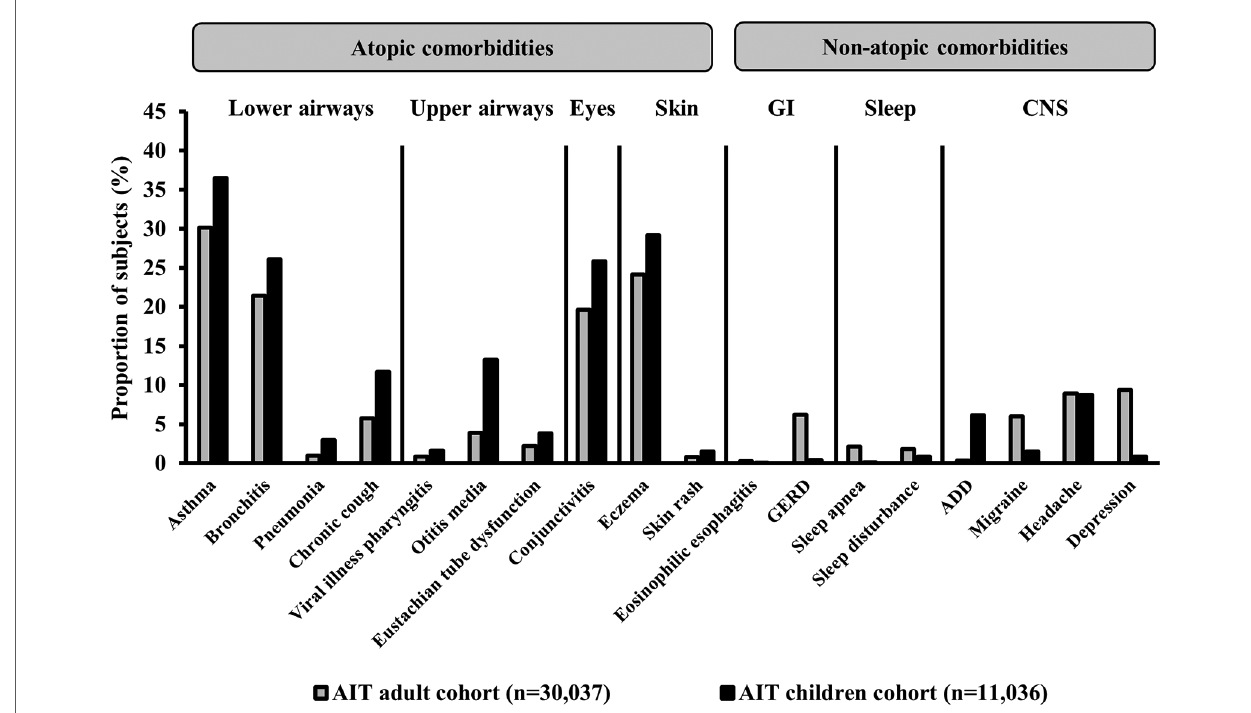
FIGURE 3 Prevalence of comorbidities in subjects with AR who had received AIT prescriptions. Data presented are from the 1-year period before the index date (i.e., the fi rst prescription for AIT during the study period) for subjects in the AIT group. ICD-10 diagnostic codes – asthma: J45.x, J46; bronchitis: J20.x, J40.x – J42, J44.x; pneumonia: J12.x – J18.x; chronic cough: R05; viral illness pharyngitis: J10.1, B00.2, B08.5, B08.8, B27.x; otitis media: H65.x – H67.x; Eustachian tube dysfunction: H68.1 – H69.x; conjunctivitis: H10.x; eczema: L20.x – L30.x, L50.x – L54.x; skin rash: R21; eosinophilic esophagitis: K20; GERD: K21.x; sleep apnea: G47.3; sleep disturbance: G47.0 – G47.2, F51.x; ADD: F90.x; migraine: G43.x; headache: R51, G44.x; depression: F32.x – F33.x. ADD, attention de fi cit disorder; AIT, allergy immunotherapy; CNS, central nervous system; GERD, gastroesophageal re fl ux disorder; GI, gastrointestinal; ICD-10, International Statistical Classi fi cation of Diseases and Related Health Problems 10th Revision.